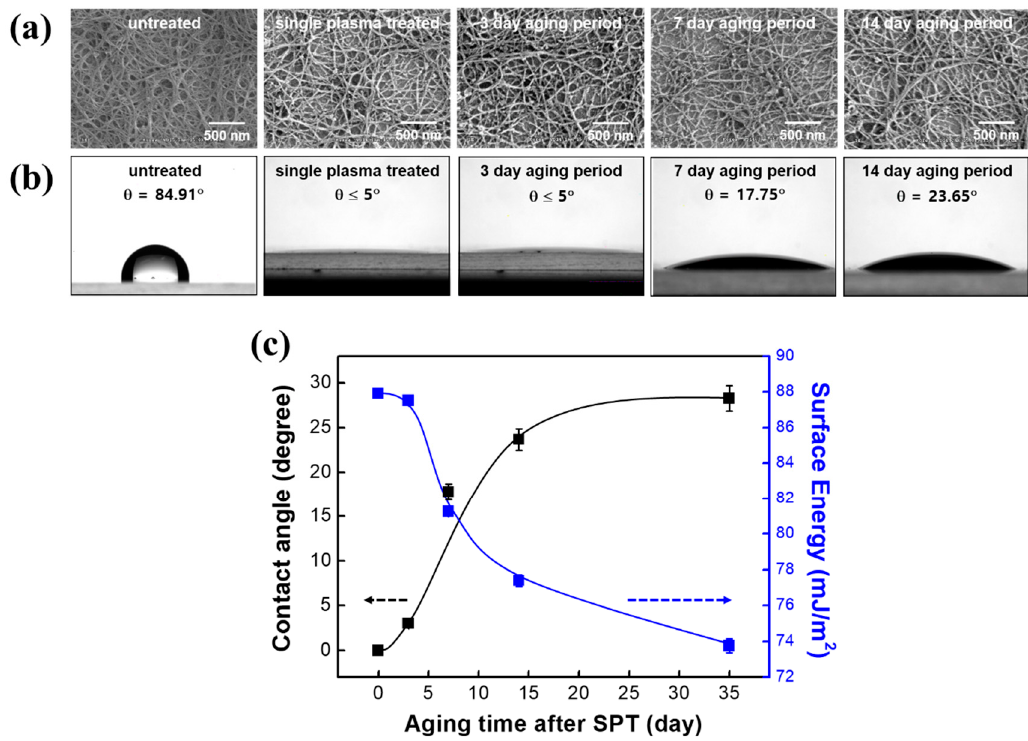
Figure 1. Changes in physical and responsive properties of SWCNT over time after the single plasma-treated (SPT) process. ( a ) SEM images; ( b ) water contact angles on the SPT-SWCNT surfaces for various aging times and ( c ) variations of the contact angle and the approximated surface energy as a function of atmospheric aging.